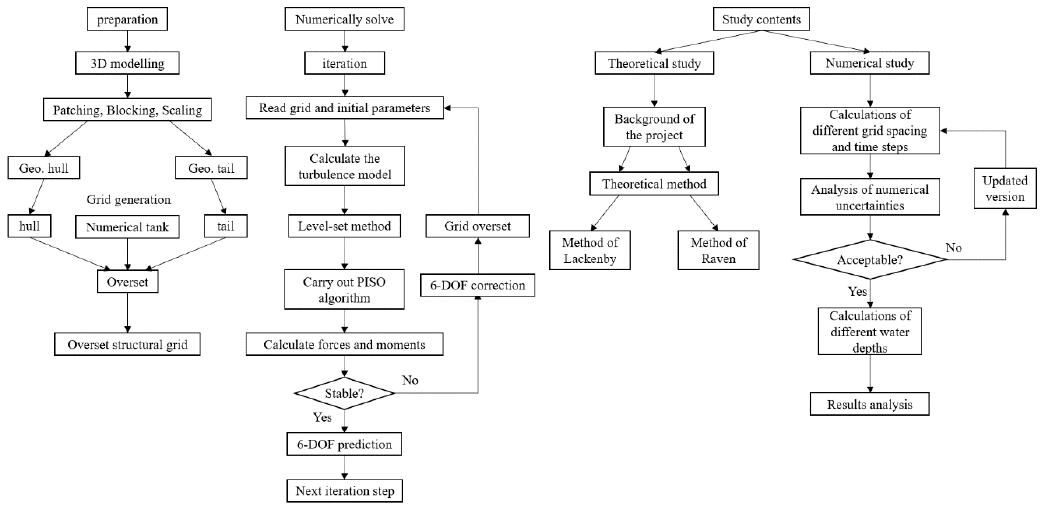
Figure 3. The workflow flowchart.